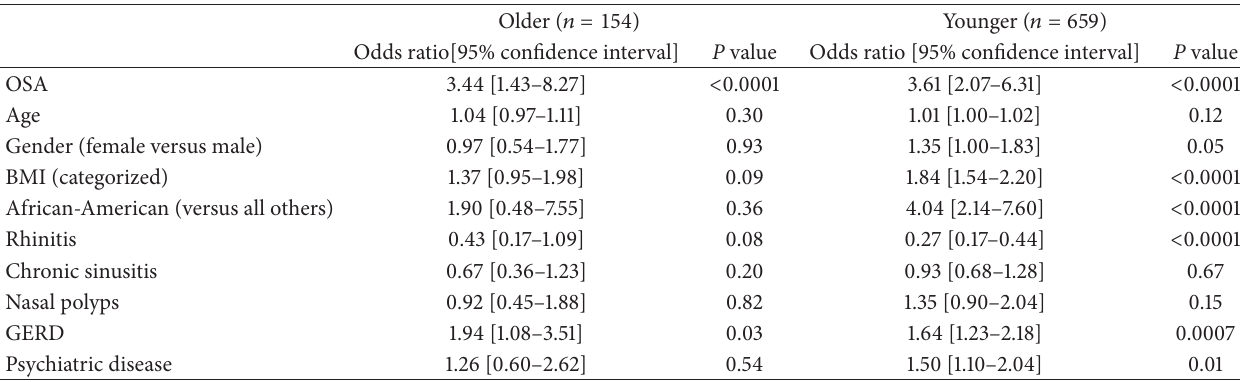
Table4:UnivariateassociationsofasthmaseveritystepwithOSA(clinically-diagnosedanduntreated)andothertraditionalfactorsofasthma control, in the older and younger asthma subjects.